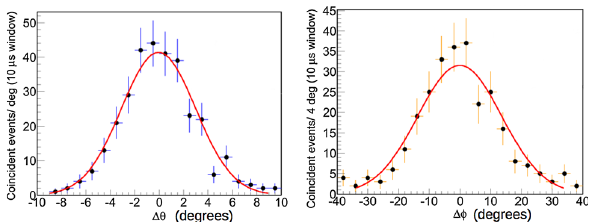
Fig. 9 Left:thedifferencebetweenthezenithanglesoftheshoweraxis (determined as the direction of the ship with respect to the ANTARES location)and ofthe reconstructedmuon underwater. Right:the samefor the azimuth angles. Fit results: Δθ mean = − 0 . 07 ◦ ± 0 . 22 ◦ ; Δφ mean = − 0 . 5 ◦ ± 0 . 8